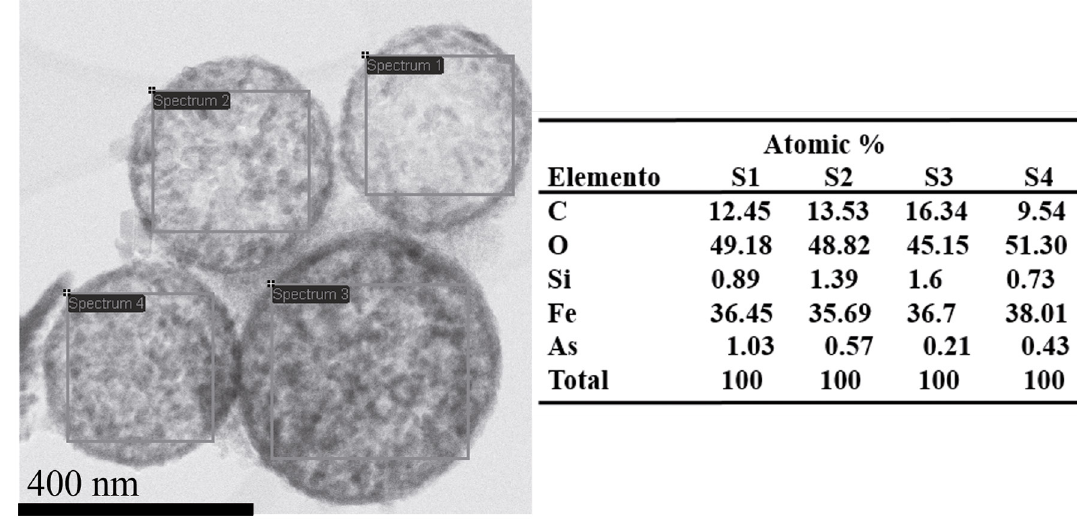
then tend to decrease when the process reached the state of equilibrium. Table 2 shows the calculated removal efficiency (%) of As ions. As observed, for As +5 ions after 10 minutes of contact time it was reached an efficiency of 95%,